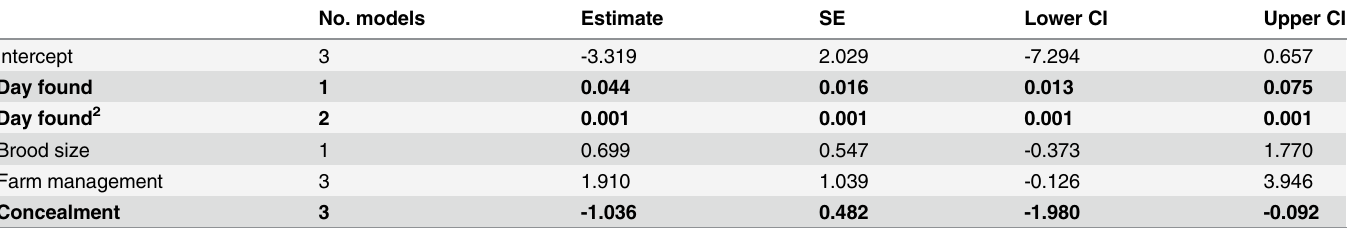
Table 5. Averaged model estimates and 95% confidence intervals from the top models predicting brood reduction (marginal R 2 = 0.53; conditional R 2 = 0.53).